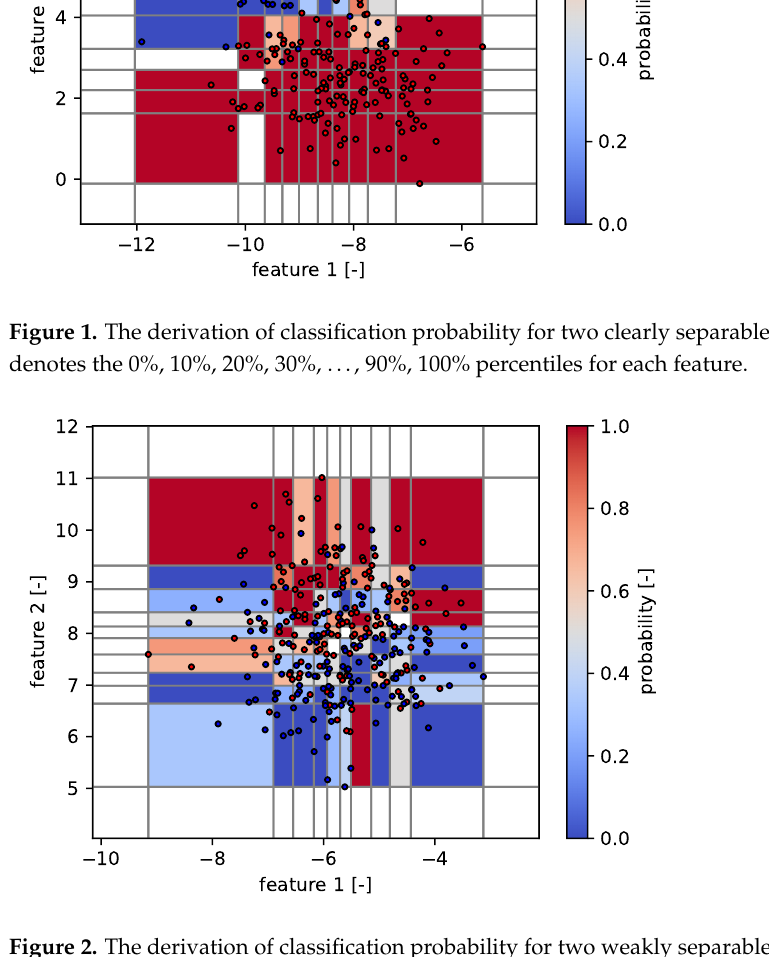
Figure 2. The derivation of classification probability for two weakly separable classes. The gray grid denotes the 0%, 10%, 20%, 30%, ..., 90%, 100% percentiles for each